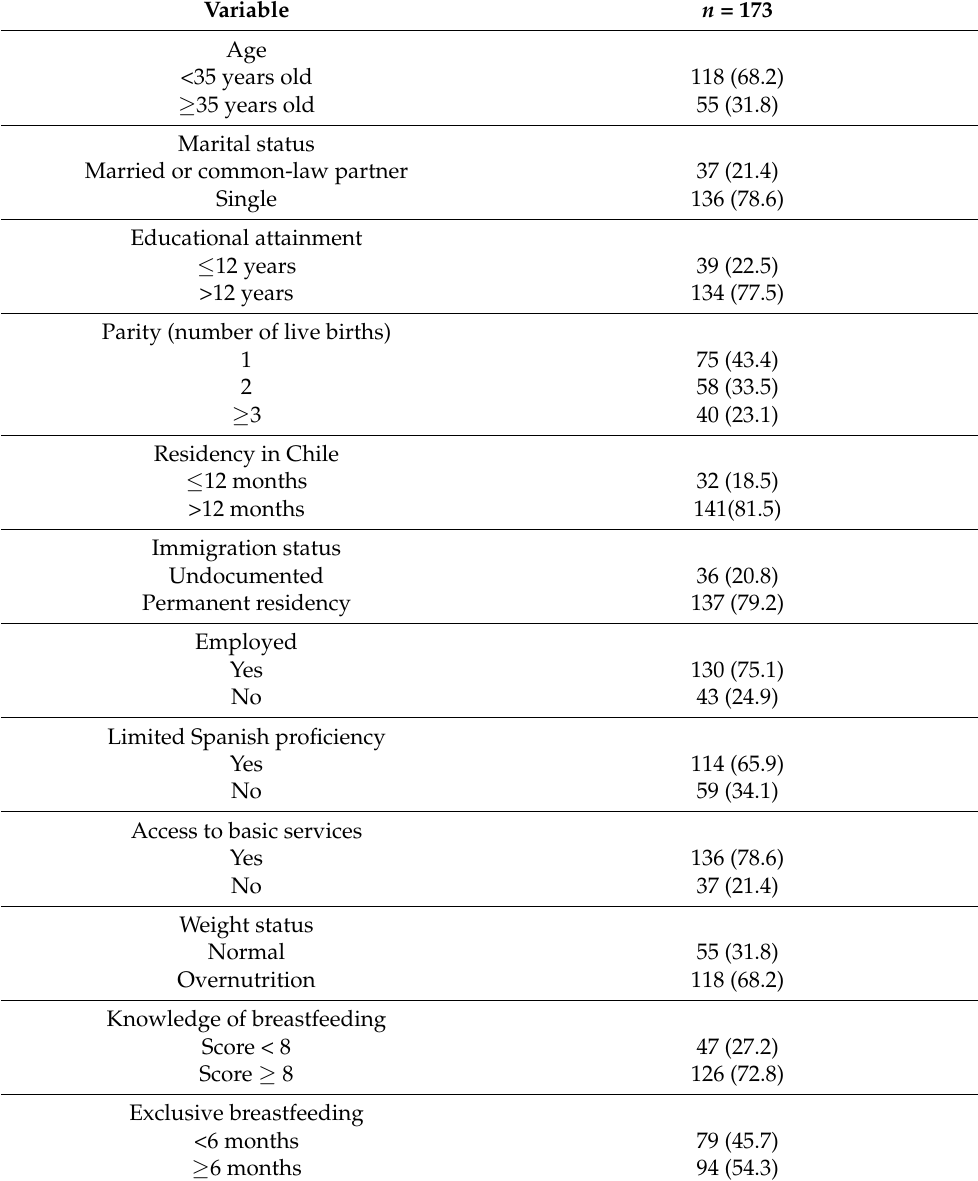
Table 1. Sociodemographic characterization of the study